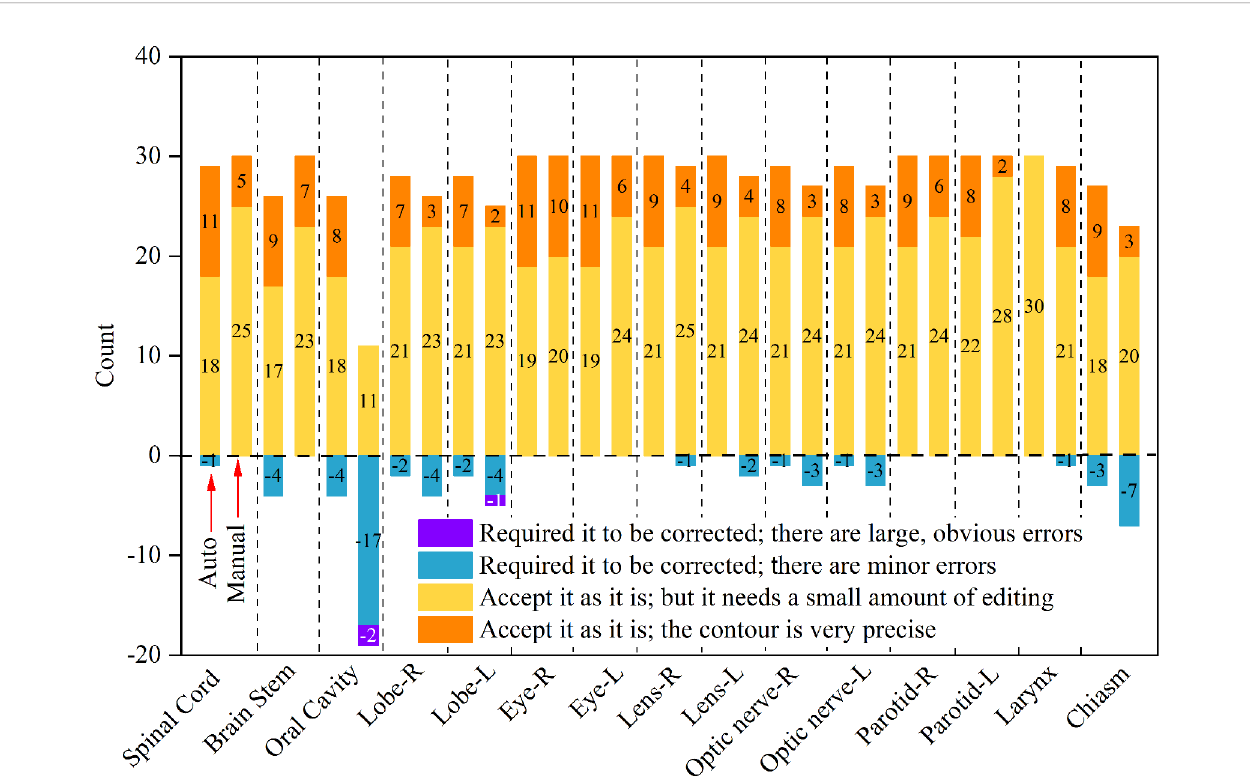
FIGURE 3 | The evaluation of the OARs for the network performance by clinicians. The left bar is the count number by the auto segmentation method and the right bar is